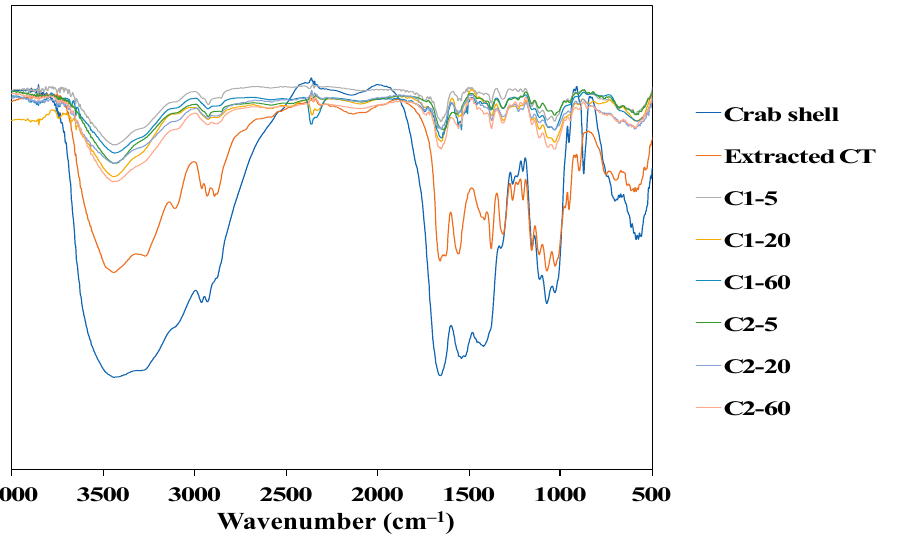
Figure 7. FTIR spectra of the crab shell, extracted chitin, and chitin fibers.